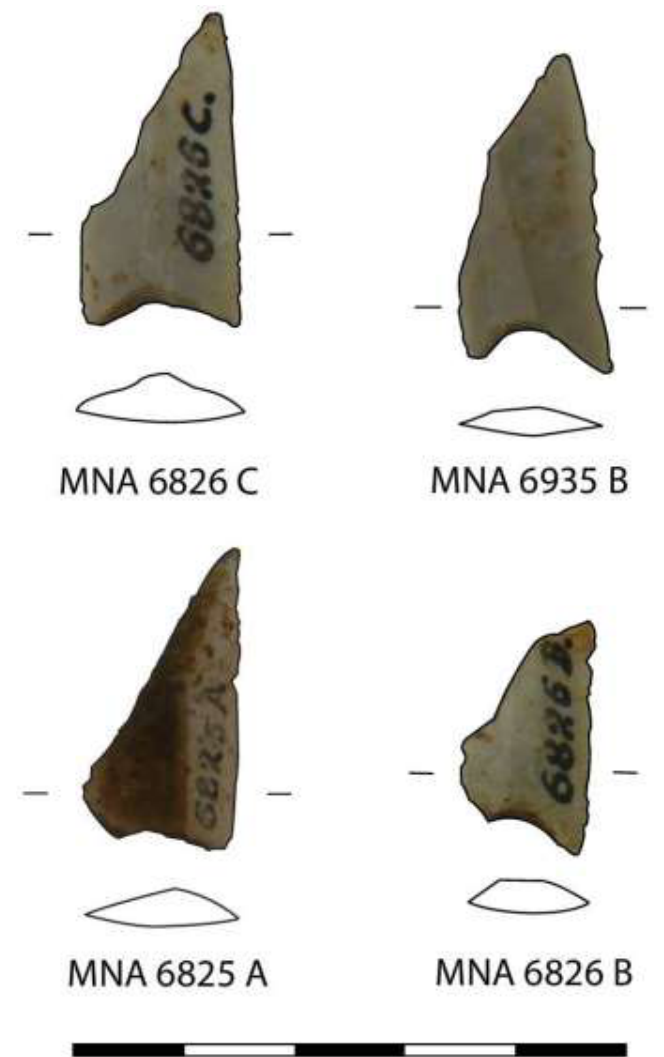
Figure 11. Geometric armatures with accentuated concave base. The scale bar is 5 cm long (in 1 cm